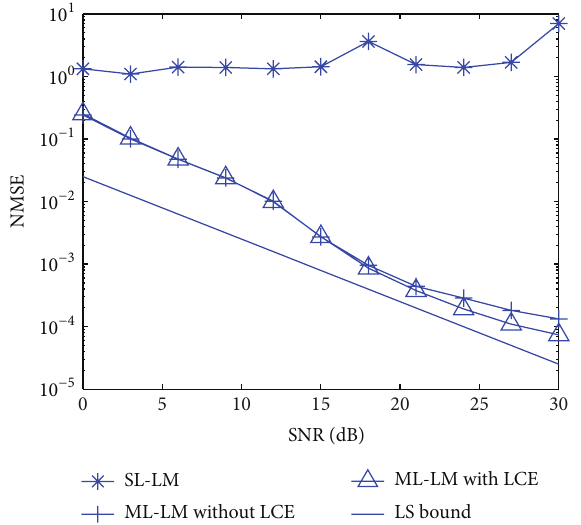
Figure8:NMSEcomparisonsofSL-LMandML-LMiterationwhen 𝐿 = 200 (with and without